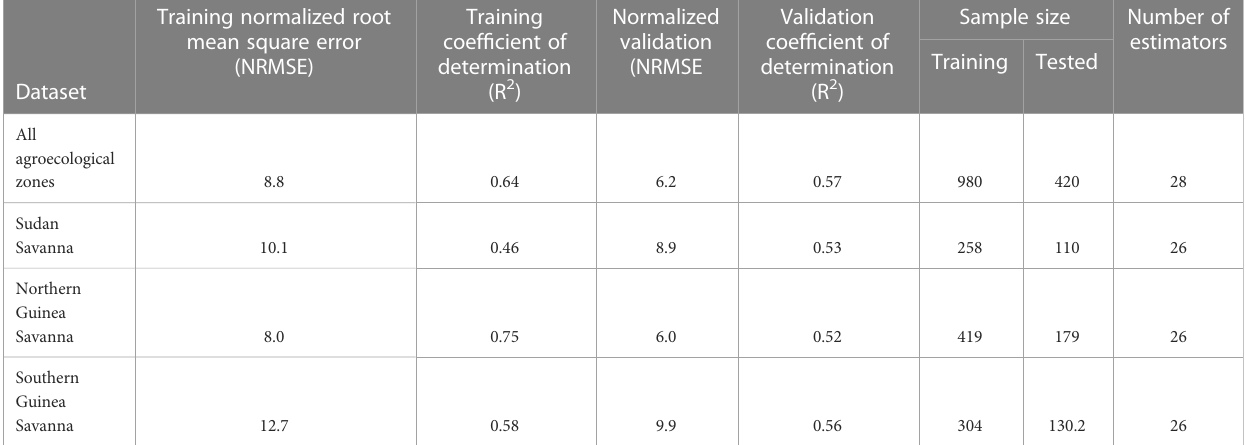
TABLE 3 Training normalized root mean square error (NRMSE) and coef fi cient of determination (R 2 ), validated NRMSE, validated R 2 , sample size, and number used estimators that predicting yield response of soybean from all sample sets, Sudan, Northern Guinea, and Southern Guinea Savannas of Nigeria.